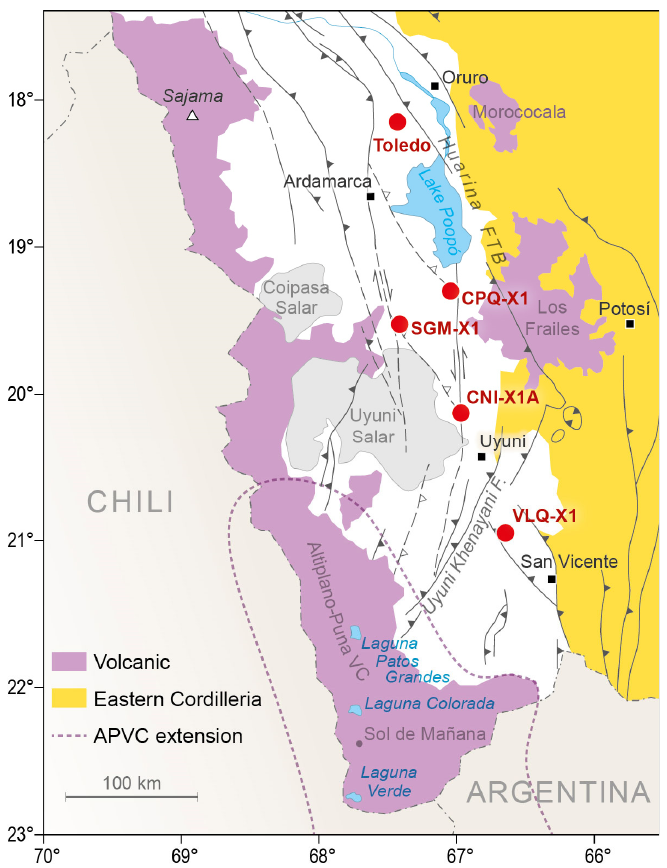
Figure 3. Simpli fi ed map of the Altiplano with the major faults, the well locations, and the studied area. Wells: CPQ, Coipasa; CNI, Colchani; SGM, Salinas de Garcia Mendoza; VLQ, Vilque. area. Wells: CPQ, Coipasa; CNI, Colchani; SGM, Salinas de Garcia Mendoza; VLQ,